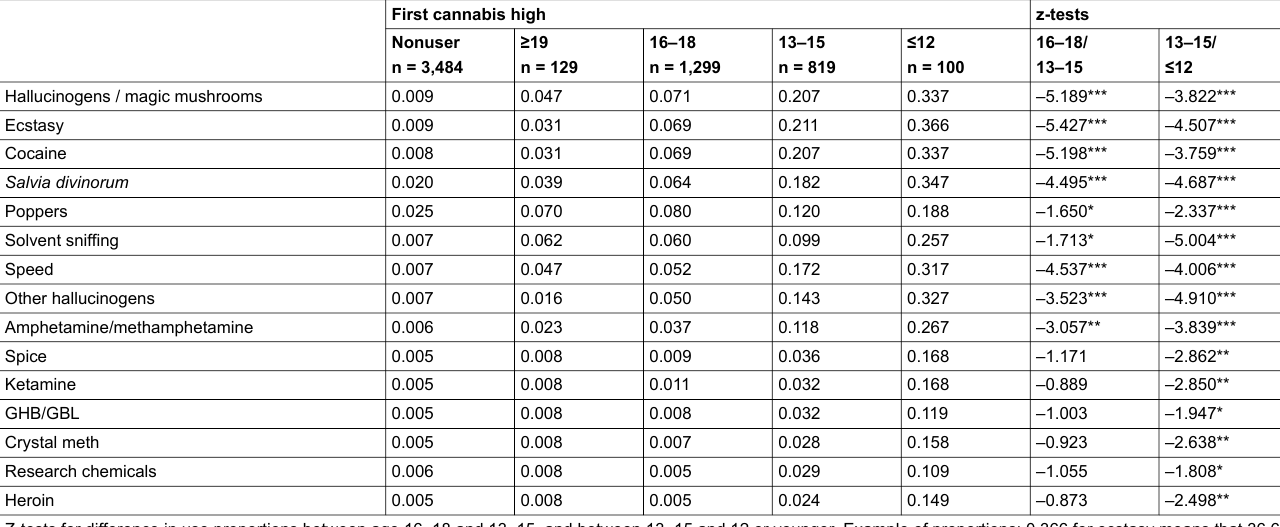
Table 5: Proportion of users of each drug within age categories of onset of intensive use of